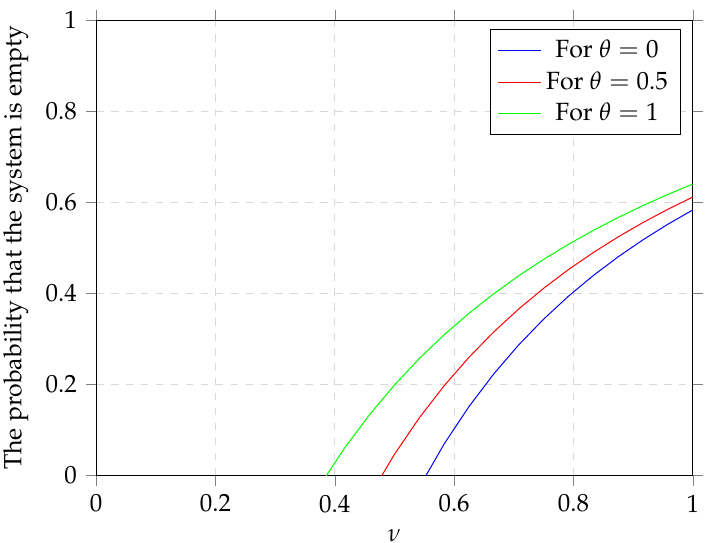
Figure 1. Probability of an empty system against ν